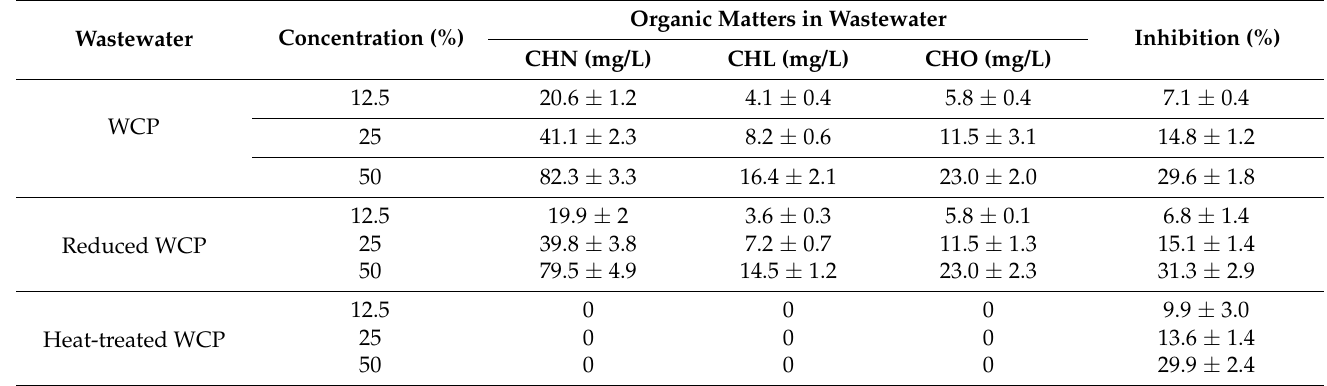
Table 2. Comparison of the organic matter contents and growth inhibition effects of